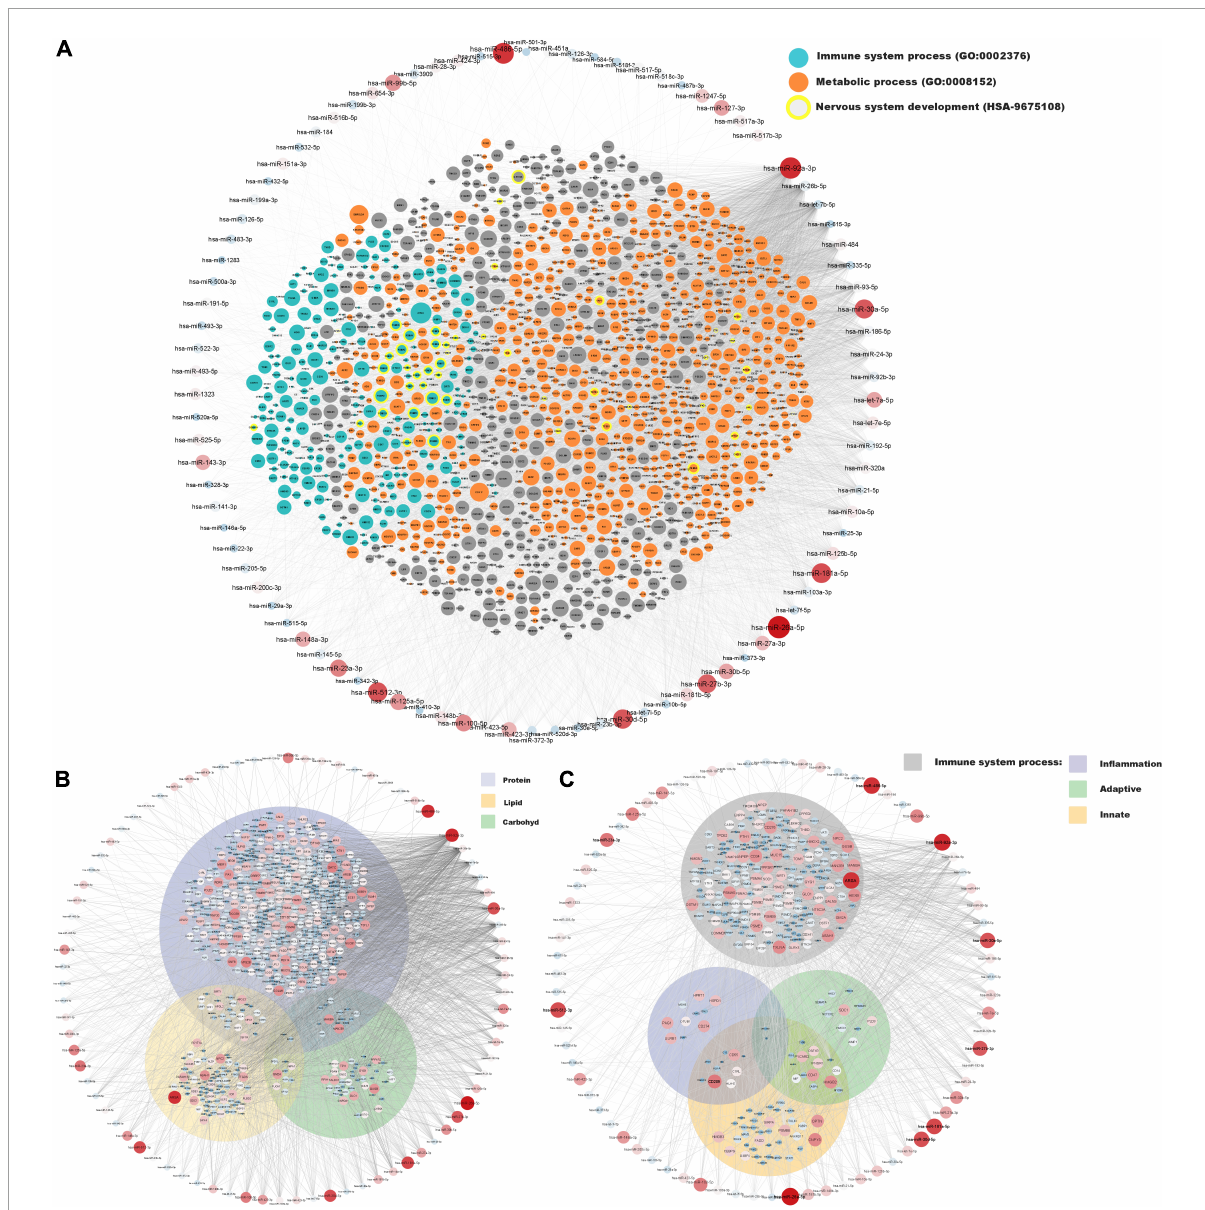
FIGURE4 miRNA and protein expressions annotated to immune system and metabolic processes in placenta. Normalised expressions of miRNAs with a z -score above zero and proteins are illustrated on a continuous scale from lowest expression (bluer smaller nodes) to highest expression (redder larger nodes) and the miRNA target links (edges) to gene products sorted with respect to their degree of edges. (A) All proteins expressed in at least 90% of placenta samples (structural proteins in Figure 3 have been removed) are shown with focused annotations to immune system process (turquoise) and metabolic process (orange) gene ontologies and nervous system development (yellow border) reactome pathway, denoted by node colour. Majority of turquoise nodes are also annotated to metabolic process (not shown). (B) Proteins annotated to metabolic process further annotated to specific metabolic processes [Protein metabolic process (GO: 0019538), Lipid metabolic process (GO: 0006629), and Carbohydrate metabolic process (GO: 0005975)] shown within their respective Venn-circular areas. (C)